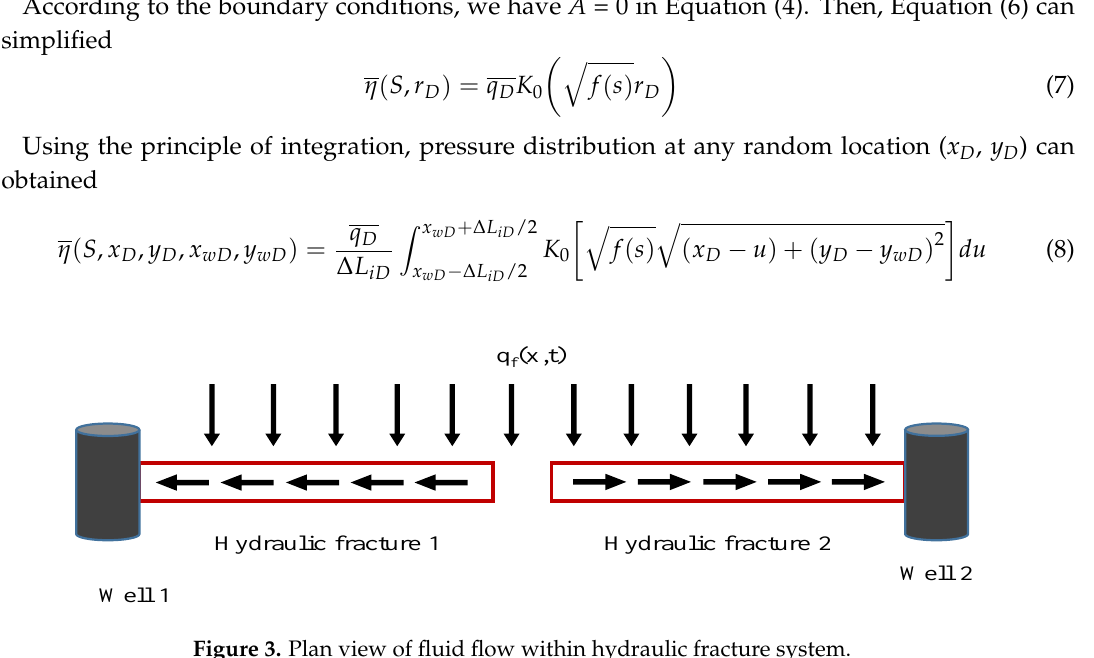
Figure 3. Plan view of fluid flow within hydraulic fracture system.